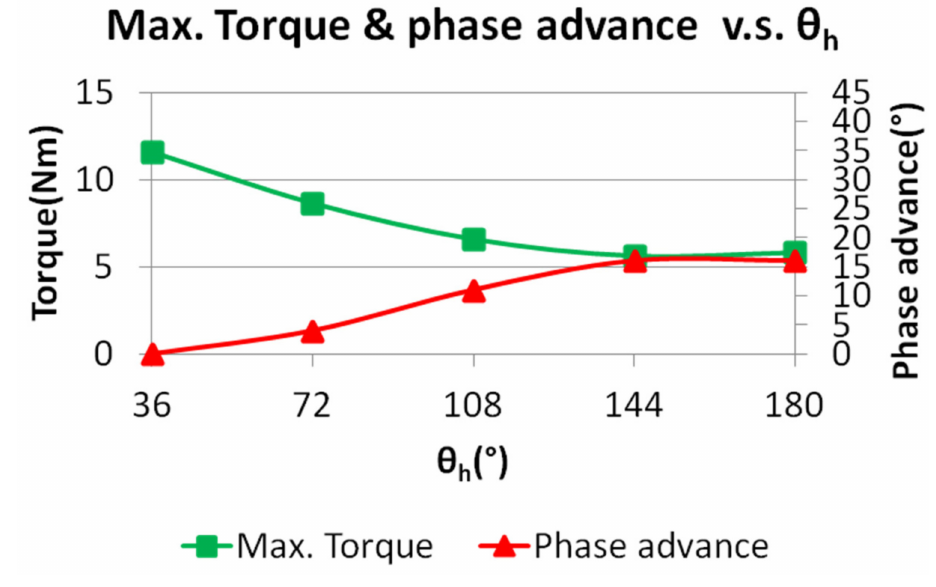
Figure 9. Maximum torque and phase advance change with θ h .